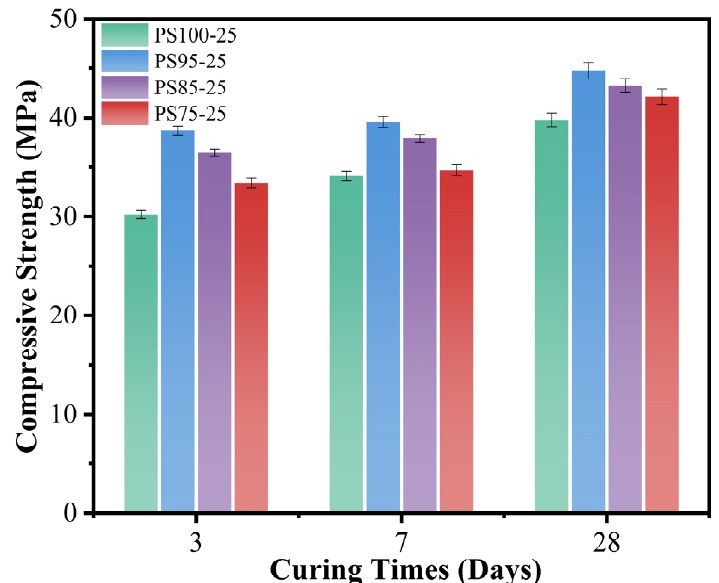
Figure 3. The compressive strength of WUFA-PS and PS-based geopolymer mortars with different WUFA substitution amounts.